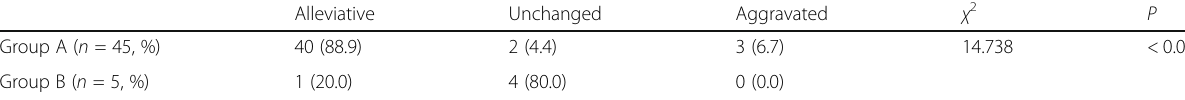
Table 2 Degrees of esophagogastric varices before and at 6 months after Rex-bypass shunt by gastroscopy